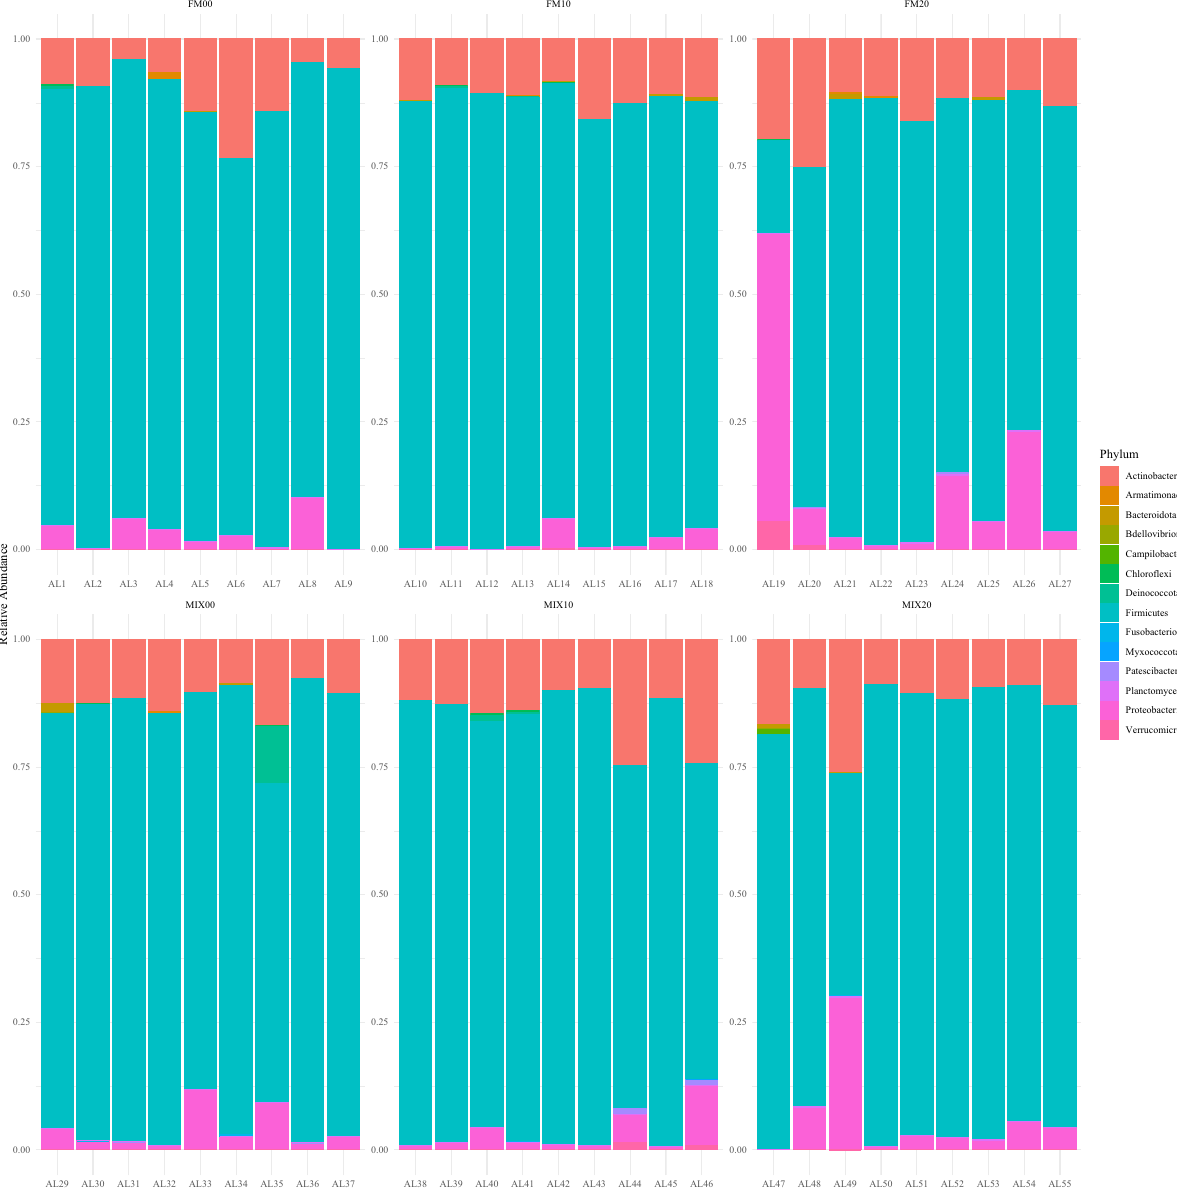
Figure 5. Stacked bar plot of gut bacterial composition using relative abundance of the most common phyla for fish from FM diets and fish from MIX diets. X axis shows sample